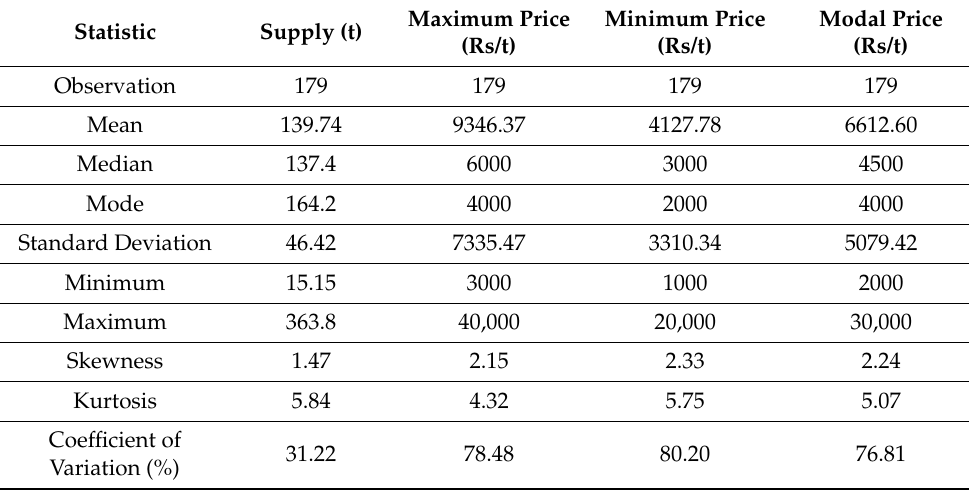
Table 1. Descriptive statistics of Gudimalakpur market .